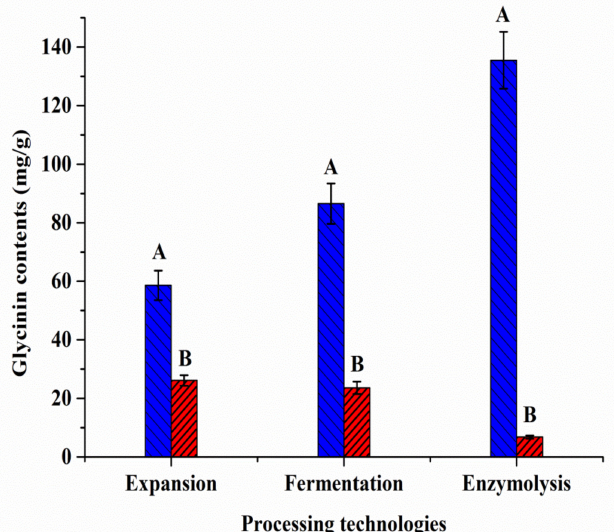
Figure 6. The glycinin contents of soybean products before (A columns) and after (B columns) different processing